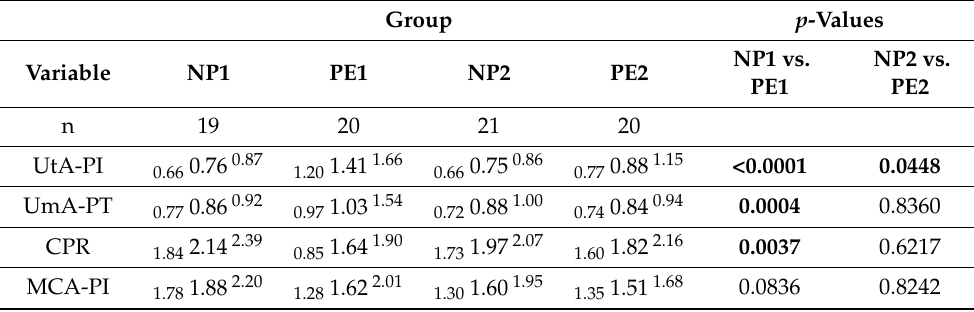
Table 2. Mean blood flow velocity in uterine, umbilical, and fetal cerebral